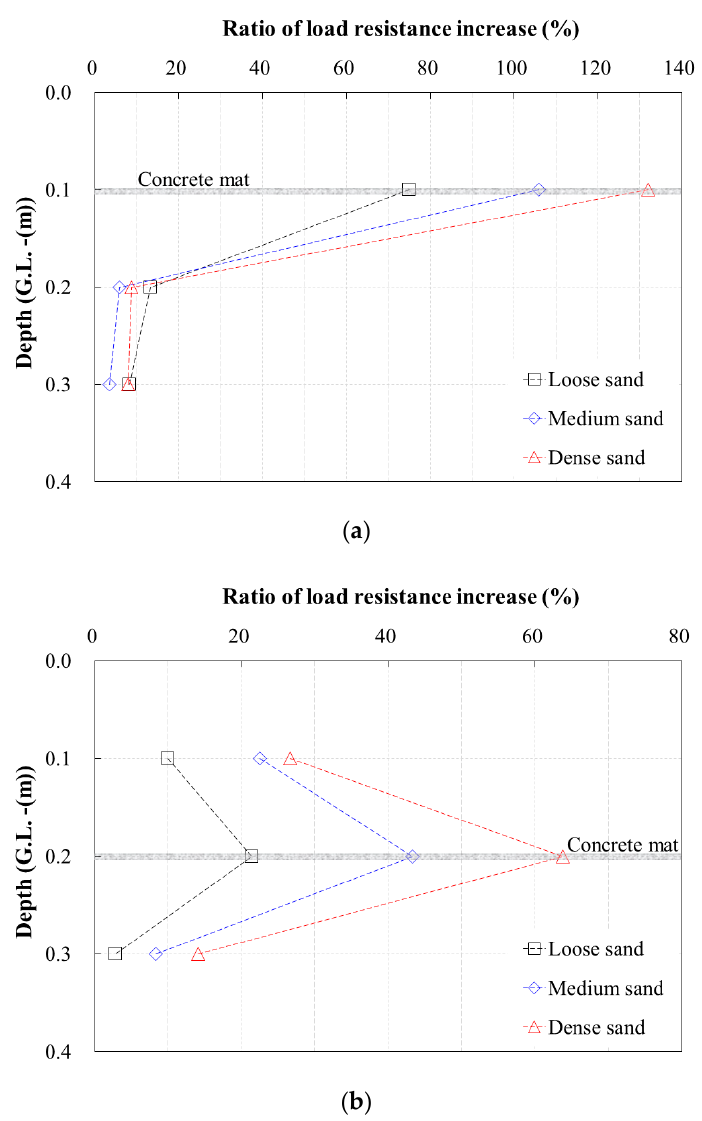
Figure 11. Ratio of the load resistance increase according to the soil density and reinforced depth: ( a ) case of a point load; ( b ) case of a uniform load.